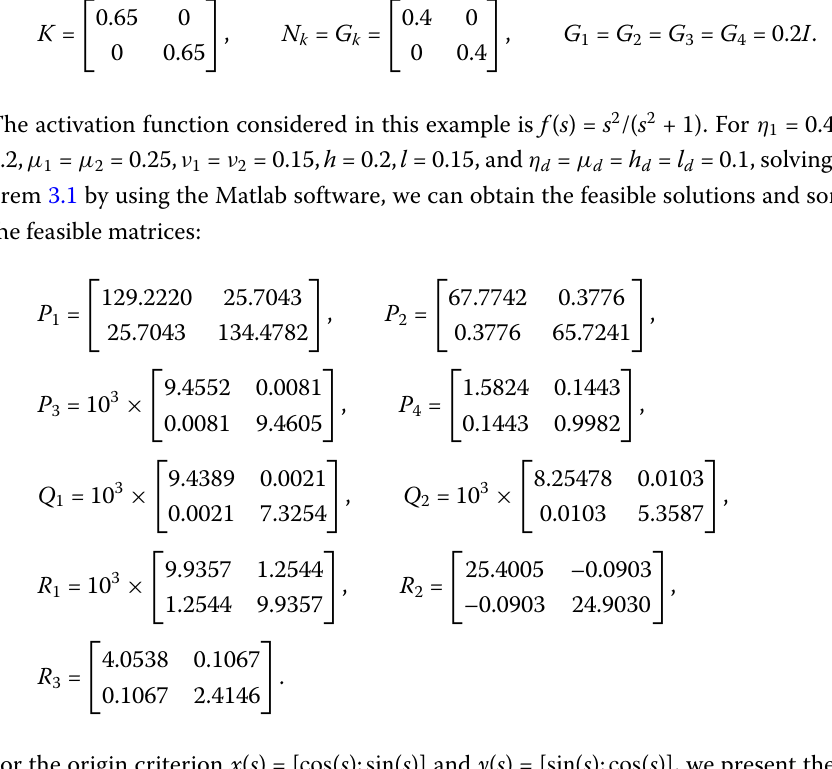
(cid:18) , G 1 = G 2 = G 3 = G 4 = 0.2 I .